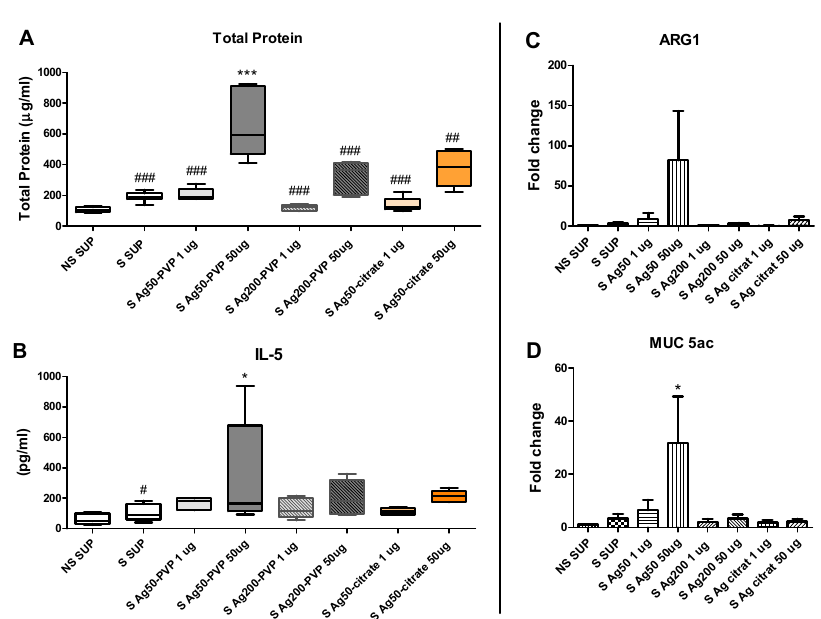
Figure 5. Ag-NPs size and surface modification significantly affects BALF total protein and cytokines and the expression of inflammatory genes. Total protein ( A ) and IL-5 ( B ) were analyzed in BALF ( n = 5–6/group) and the expression of Arg1 ( C ) and Muc5ac ( D ) was analyzed in lung homogenates ( n = 3–4/group); lungs were retrieved on day 53, 24 h after NPs or particle-free supernatant (SUP) instillation and OVA challenge. The groups are depicted underneath. White plots represent SUP controls and filled/colored plots represent NP-treated groups. * p < 0.05, *** p < 0.001 vs. NS SUP; # p < 0.05, ## p < 0.01, ### p < 0.001 vs. 50 µg Ag50-PVP.